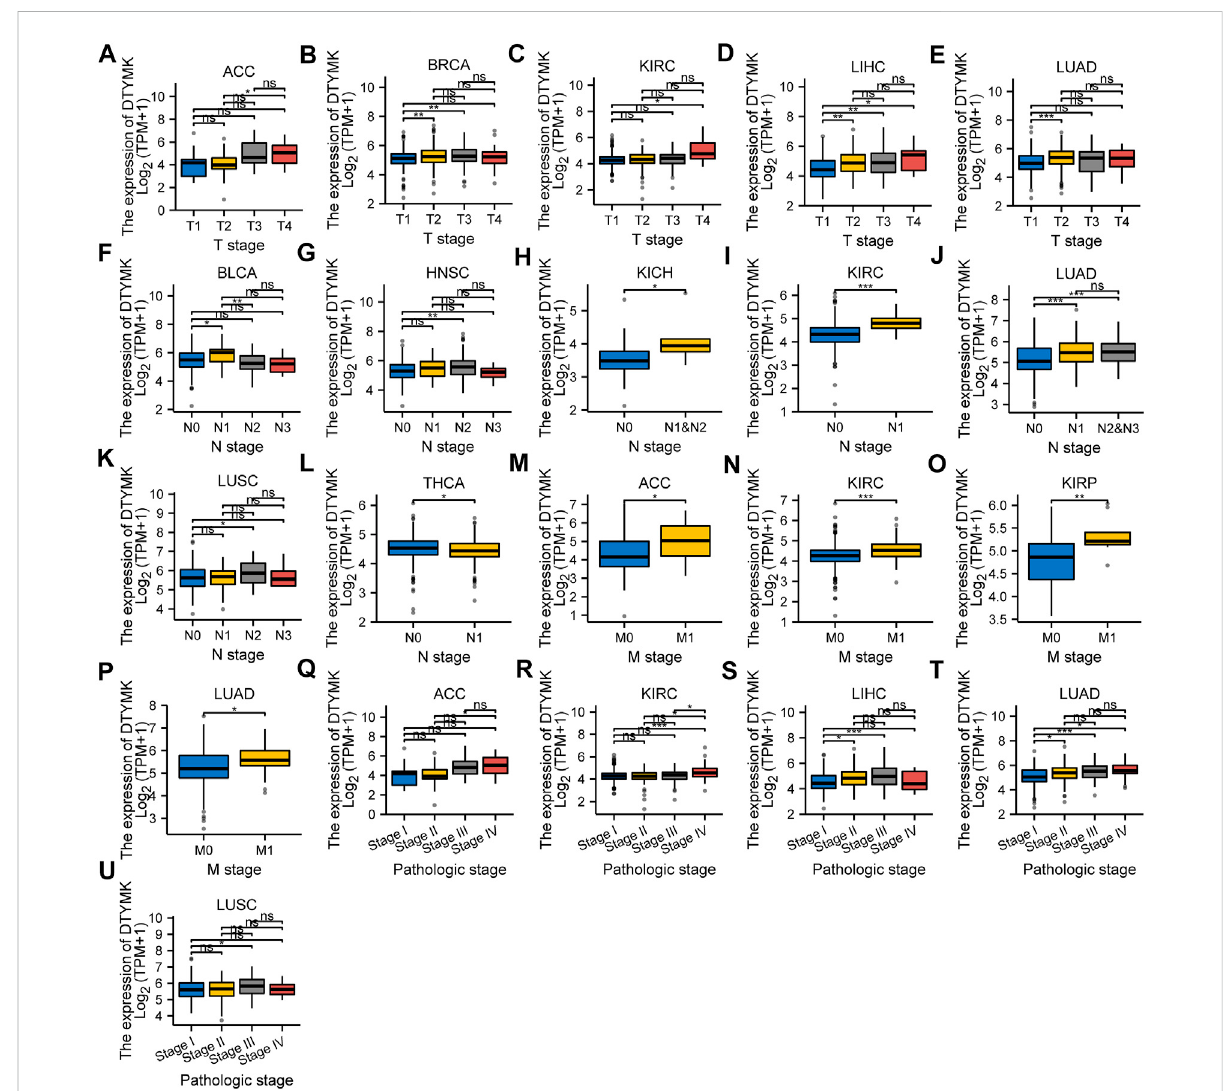
FIGURE 9 The correlation between DTYMK expression and clinicopathological characteristics. The correlation between DTYMK expression with the T stage in ACC, BRCA, KIRC, LIHC, and LUAD (A – E) , the N stage in BLCA, HNSC, KICH, KIRC, LUAD, LUSC, and THCA (F – L) , the M stage in ACC, KIRC, KIRP, and LUAD (M – P) , and TNM stage in ACC, KIRC, LIHC, LUAD, and LUSC (Q – U) . (ns, no signi fi cant; *, p < 0.05, **, p < 0.01, ***, p <